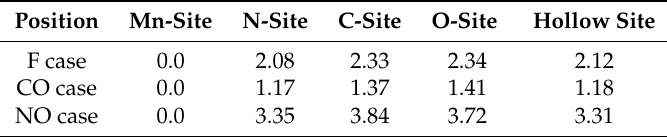
Figure 2. Schematic view of the proposed Mn-salophen molecular junction, here, the symbols stand for the examined adsorption sites. Table 1. Adsorption energies (in eV) on different